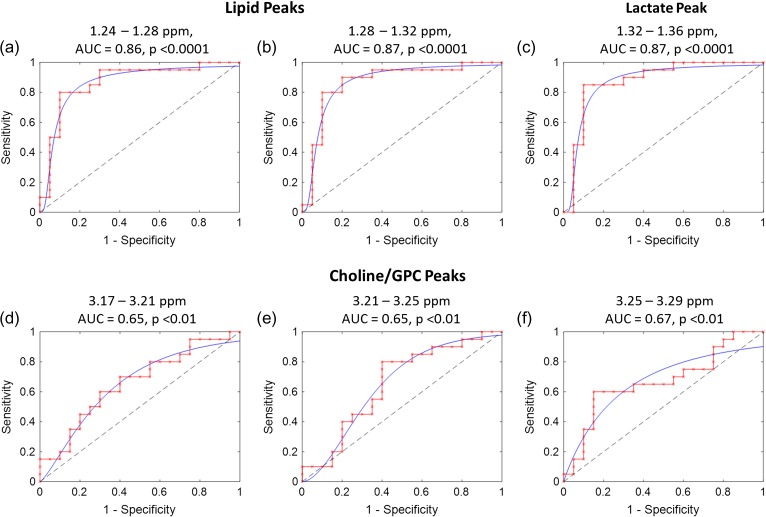
ROC curve analysis of 1H MRS spectrum identified as being significantly different between ‘40%’ and ‘80%’ sperm populations by two-way ANOVA. Six spectrum bins were found using two-way ANOVA (spectrum bins and sperm populations) in two distinct regions of the 1H MRS spectrum; choline/GPC (3.17–3.29 ppm), lactate (1.32–1.36 ppm) and lipid (1.24–1.32 ppm). The ability of each of these bins to discriminate between sperm populations was analyzed using ROC curves; Panels (a)–(c) lactate/lipid region, Panels (d)–(e) choline/GPC.